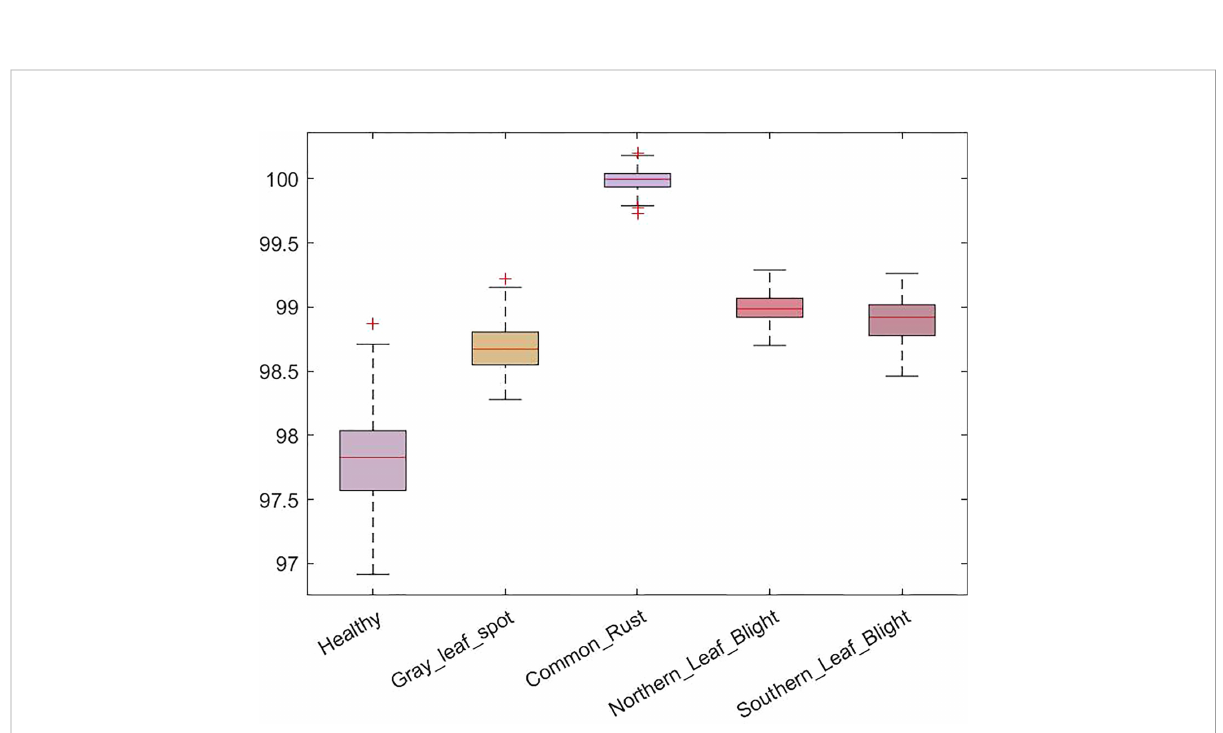
FIGURE 8 Box-plot of the accuracy for the proposed method on the test